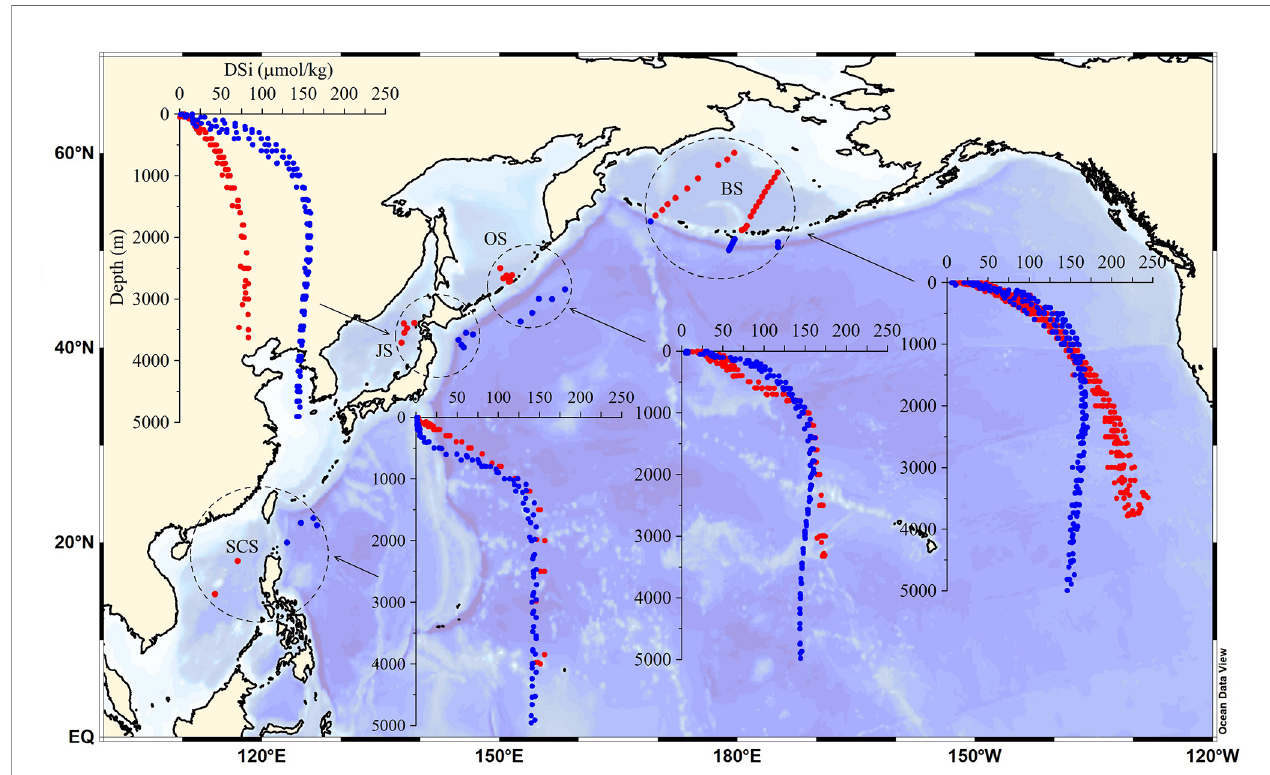
FIGURE 2 | Differences in deep-sea DSi concentration in different marginal seas (red dots) and their adjacent Paci fi c waters (blue dots). The marginal seas include the Bering Sea (BS), Okhotsk Sea (OS), Japan Sea (JS), and South China Sea (SCS). ( D DSi (bottom – 2000m) , µmol/kg). The D DSi (bottom – 2000m) value in the Bering Sea is 32.8 ± 4.0 µmol/kg ( Figure 3 ), whereas the D DSi (bottom – 2000m) values in the Okhotsk Sea, Japan Sea, and South China Sea are 5.8 ± 2.6, 3.1 ± 2.5, and − 0.5 ± 0.7 µmol/kg,